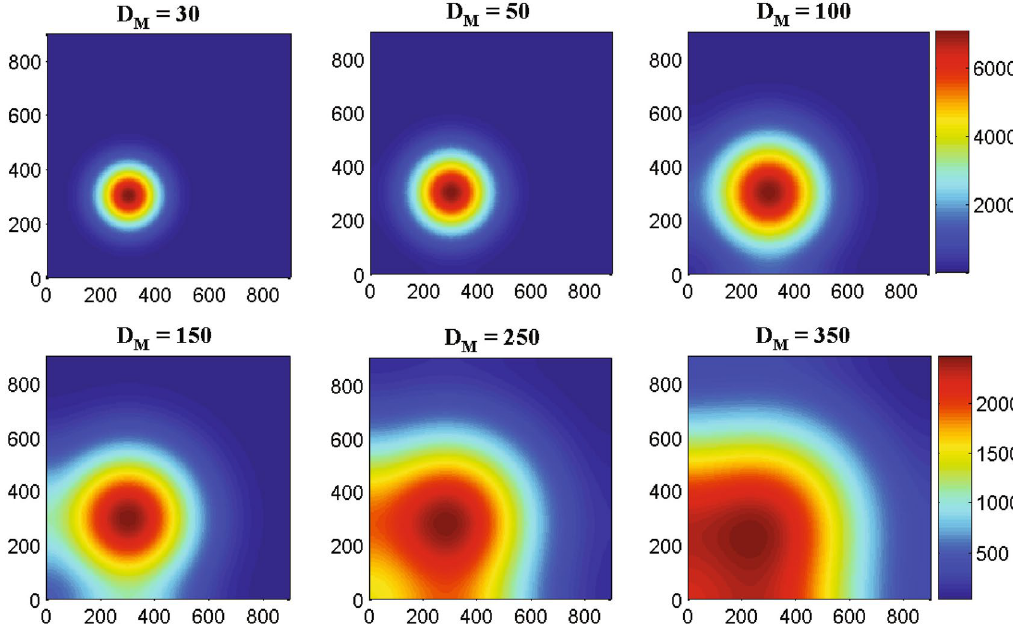
Figure 10. The two-dimensional sequence of profiles designates the evolution of the macrophages density M ( t , x , y ) at time T = 100 hrs ( ∼ 4 days ) and for different rate of diffusion of macrophages corresponding to 30, 50, 100, 150, 250 and 350 respectively. The simulations shows the spread of macrophages density for an increasing value of the rate of random motility. Parameter values: D G = 55 , D T = 400 , D C = D I = 25 and the other parameter values and initial conditions are presented in the Table